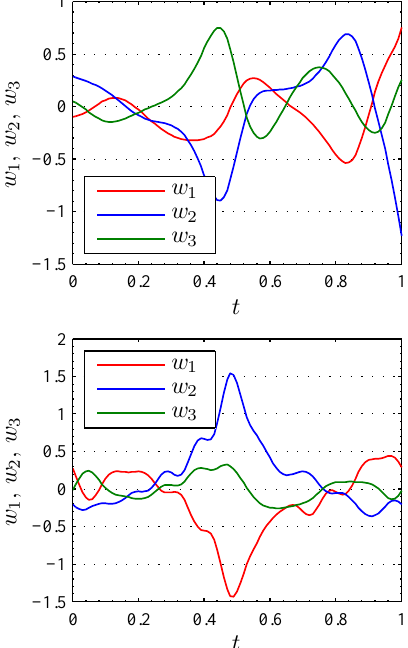
Figure 8. Original control w ( t ): egalitarian solution (top) and prio- ritarian solution